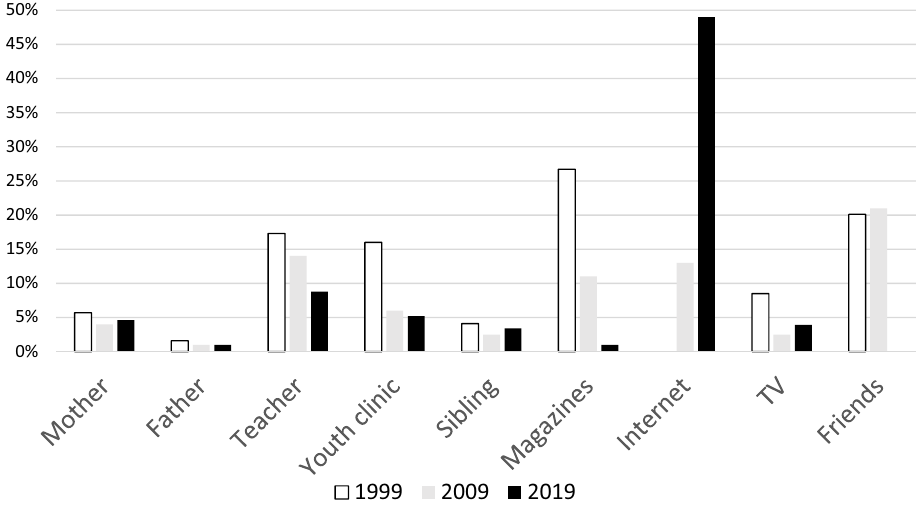
Figure 1. Primary source of information about sex among first-year high schools students in 1999, 2009 and